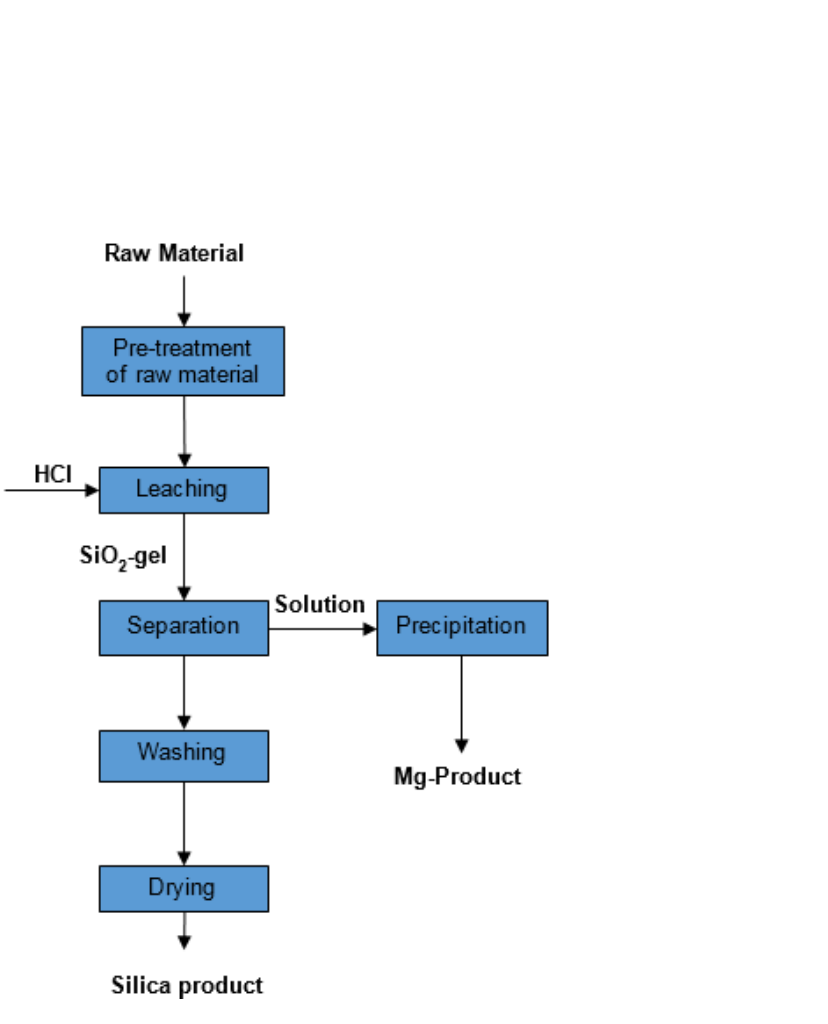
Figure 4 – Acidic method for the synthesis of silica (Olerud, 1998) Рис . 4 – Кислотный метод для синтеза диоксида кремния (Olerud, 1998) Слика 4 – Синтеза силицијум - диоксида методом растварања оливина киселином (Olerud,